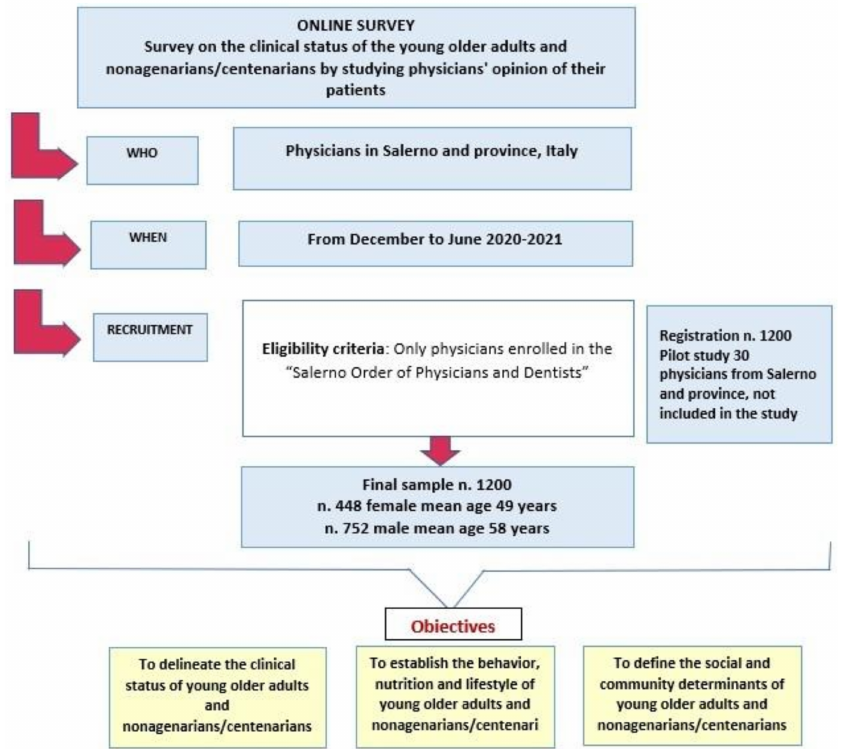
Figure 1. Survey design, including data collection, participant recruitment, and objectives. Detailed information can be found in the introduction, study design, and results